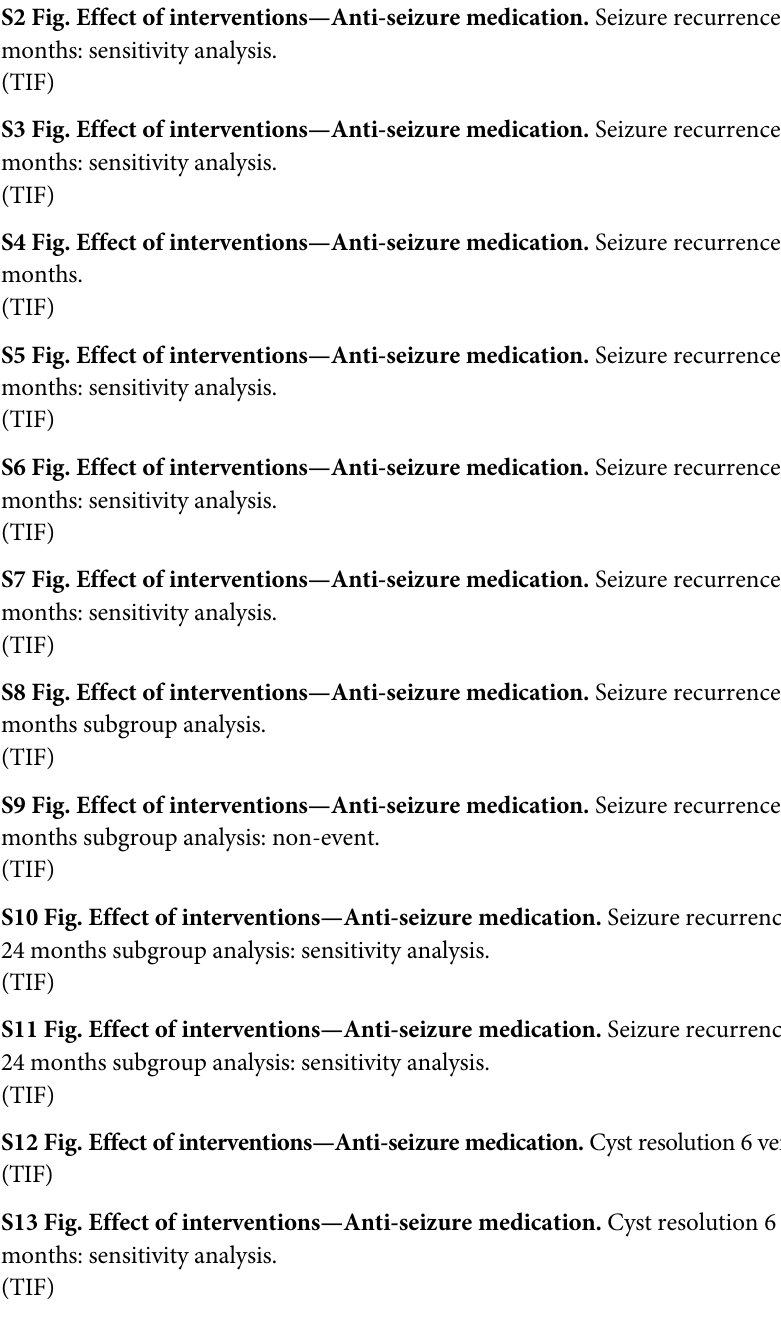
S1 Fig. Effect of interventions—Anti-seizure medication. Seizure recurrence 6–12 versus 24 months. S2 Fig. Effect of interventions—Anti-seizure medication. Seizure recurrence 6–12 versus 24 months: sensitivity analysis. S3 Fig. Effect of interventions—Anti-seizure medication. Seizure recurrence 6–12 versus 24 months: sensitivity analysis. S4 Fig. Effect of interventions—Anti-seizure medication. Seizure recurrence 6 versus 12–24 months. S5 Fig. Effect of interventions—Anti-seizure medication. Seizure recurrence 6 versus 12–24 months: sensitivity analysis. S6 Fig. Effect of interventions—Anti-seizure medication. Seizure recurrence 6 versus 12–24 months: sensitivity analysis. S7 Fig. Effect of interventions—Anti-seizure medication. Seizure recurrence 6 versus 12–24 months: sensitivity analysis. S8 Fig. Effect of interventions—Anti-seizure medication. Seizure recurrence 6–12 versus 24 months subgroup analysis. S9 Fig. Effect of interventions—Anti-seizure medication. Seizure recurrence 6–12 versus 24 months subgroup analysis: non-event. S10 Fig. Effect of interventions—Anti-seizure medication. Seizure recurrence 6–12 versus 24 months subgroup analysis: sensitivity analysis. S11 Fig. Effect of interventions—Anti-seizure medication. Seizure recurrence 6–12 versus 24 months subgroup analysis: sensitivity analysis. S12 Fig. Effect of interventions—Anti-seizure medication. Cyst resolution 6 versus 24 months. (TIF) S13 Fig. Effect of interventions—Anti-seizure medication. Cyst resolution 6 versus 24 months: sensitivity